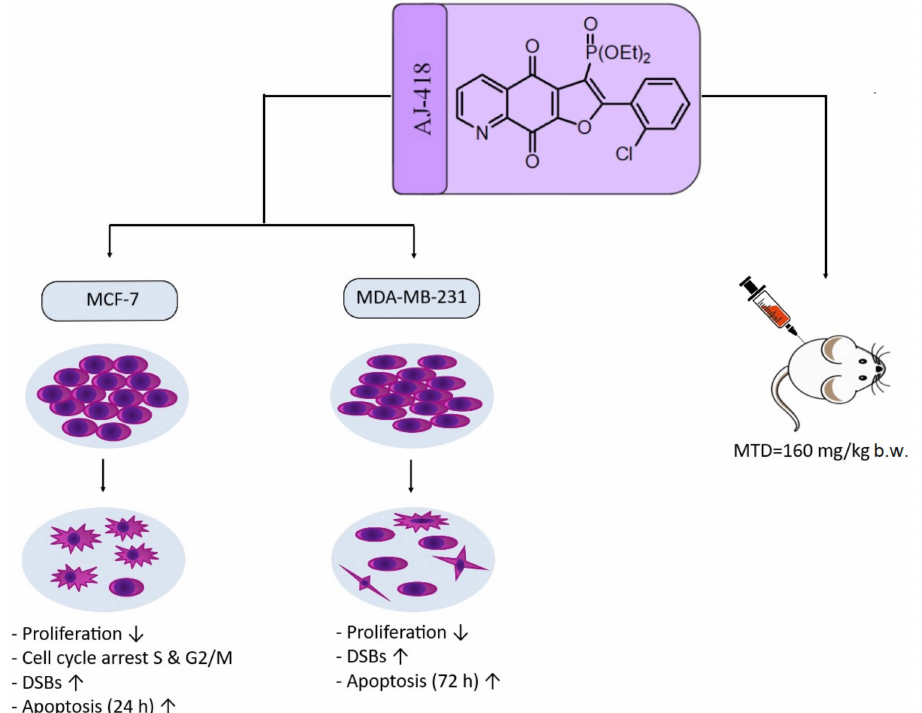
Figure 10. Schematic representation of the effect of quinolinedione AJ-418 on MCF-7 and MDA-231 cells and evaluation of MTD in C3H